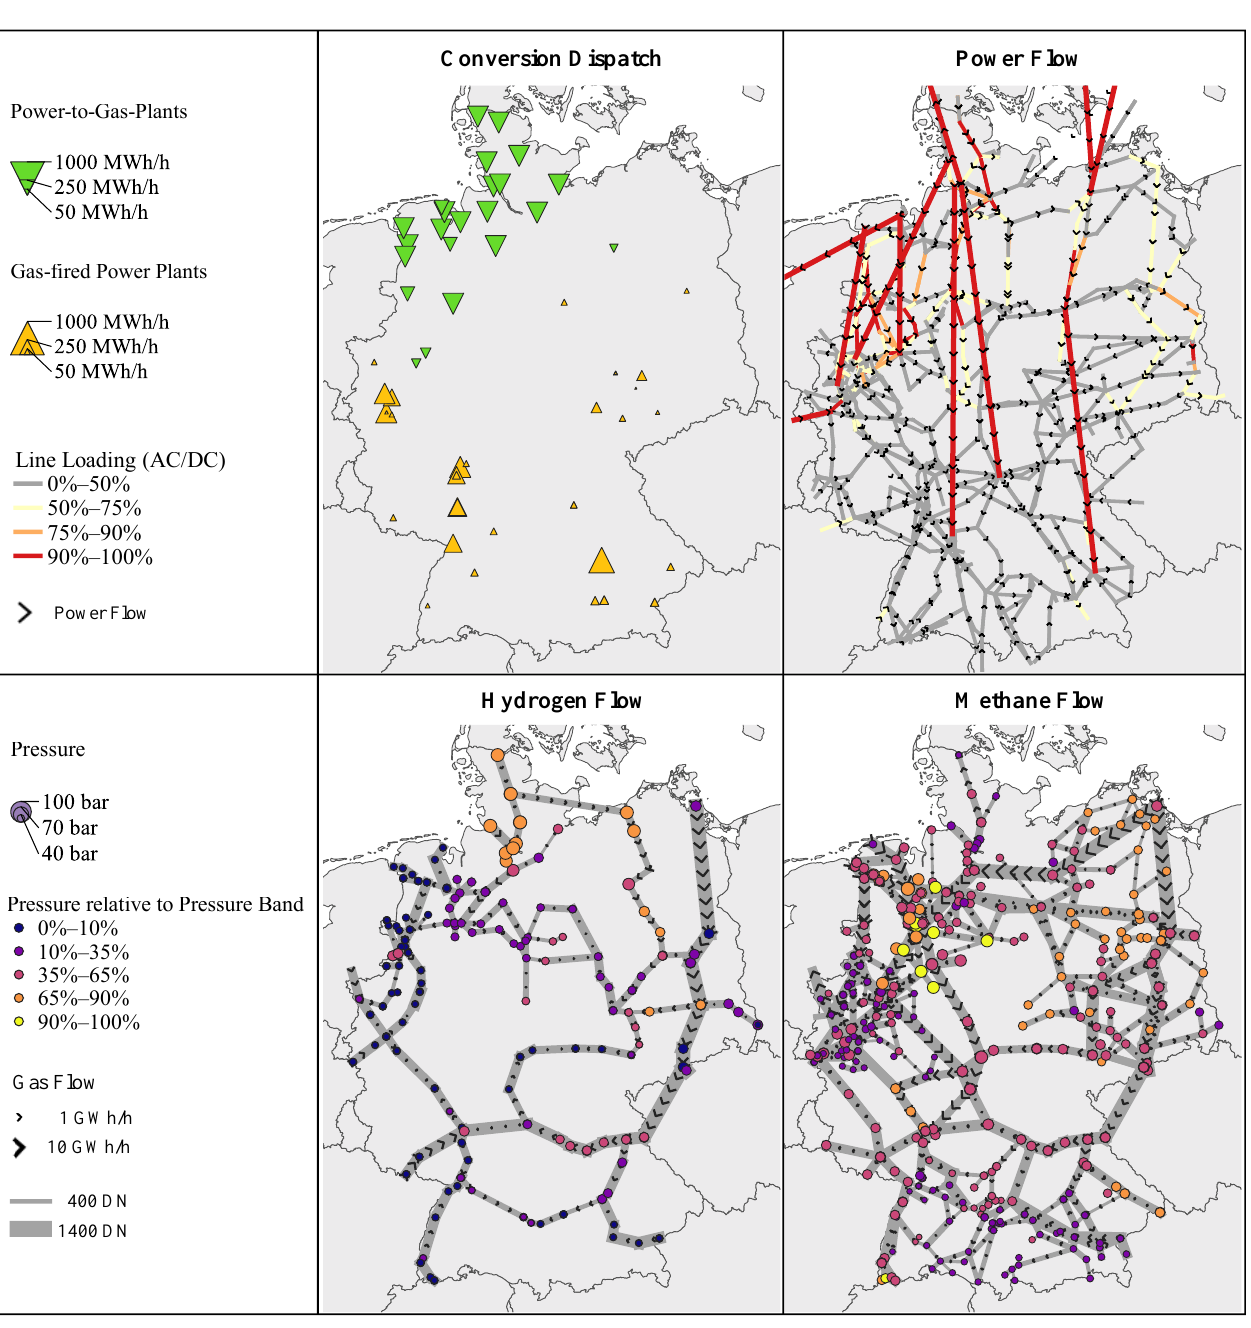
Figure 6. Detailed dispatch results for stressful snapshot in Germany: conversion dispatch ( top left ), electric power flow ( top right ), hydrogen gas flow ( bottom left ), natural gas (methane) gas flow ( bottom right ), (model result).